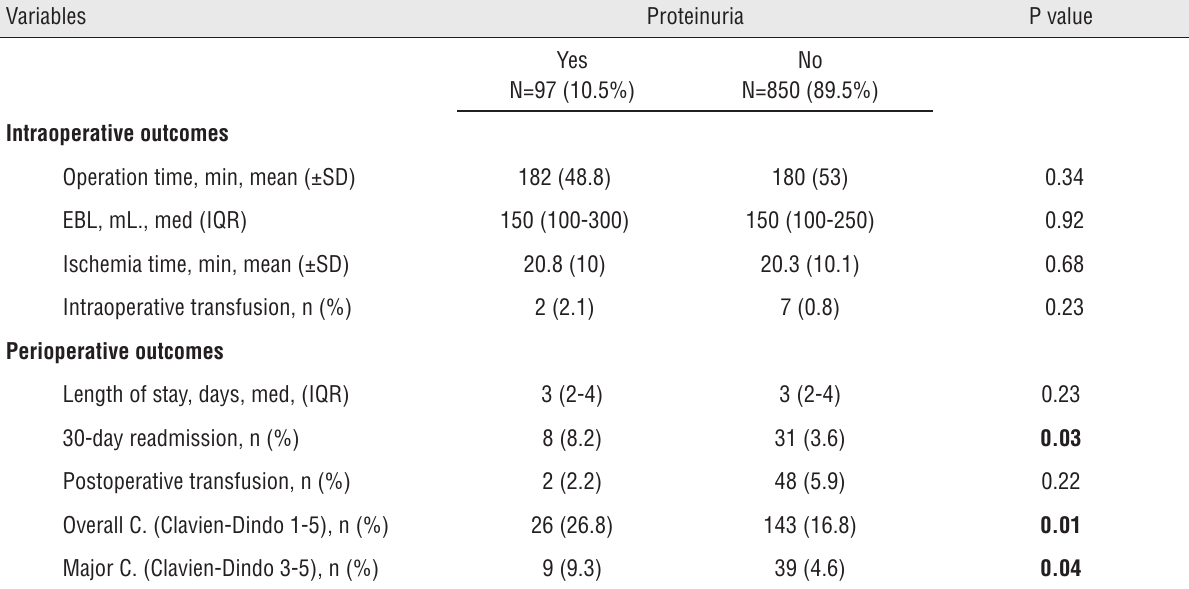
Table 3 - Secondary